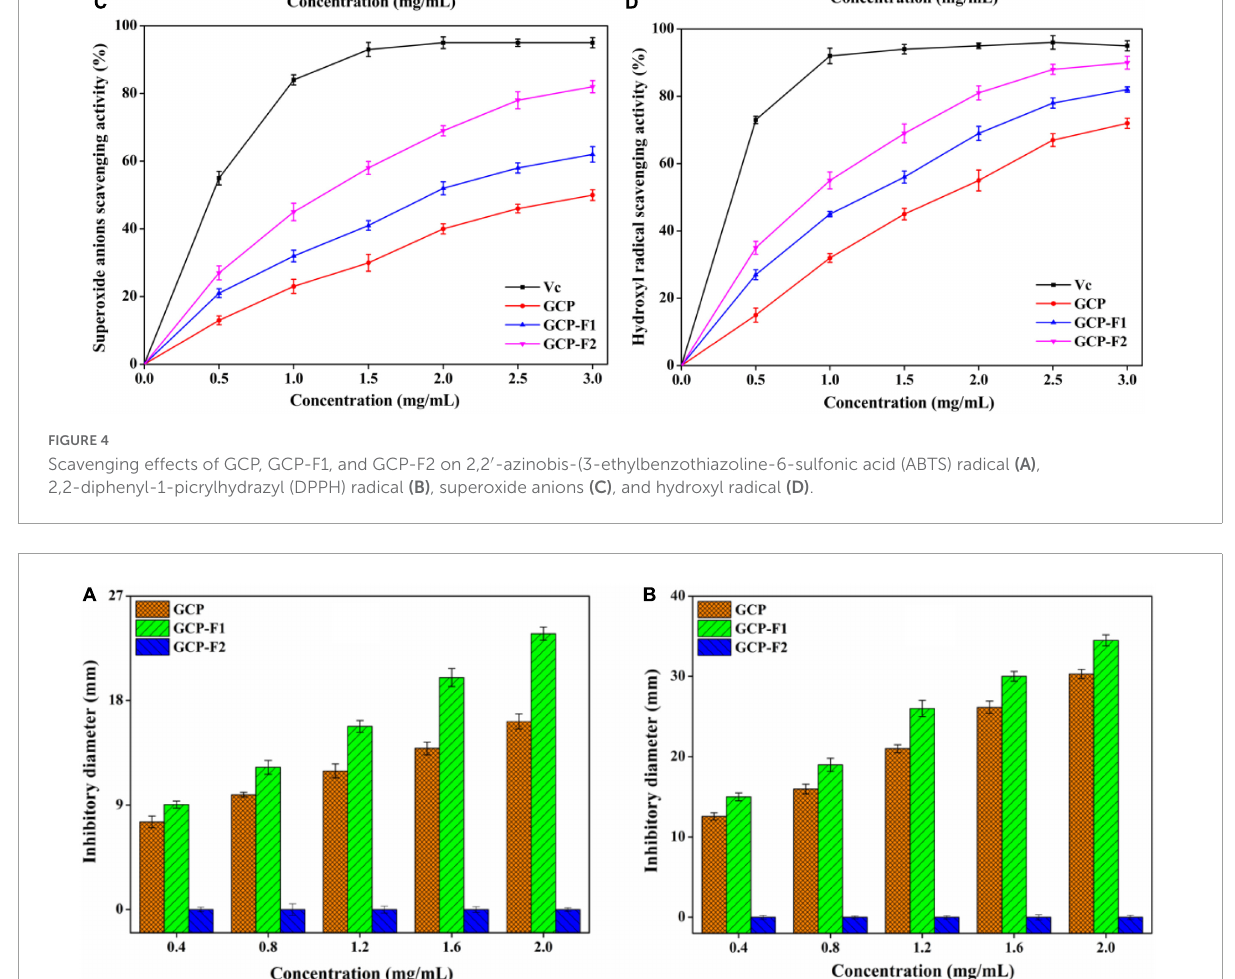
GCP, 72.31 ± 1.88%, 76.04 ± 1.37%, 61.97 ± 2.35%, and 81.07 ± 0.86% for GCP-F1, and 83.55 ± 2.31%, 85.08 ± 2.21%, 82.16 ± 1.84%, and 90.08 ± 1.94% for GCP-F2, respectively.